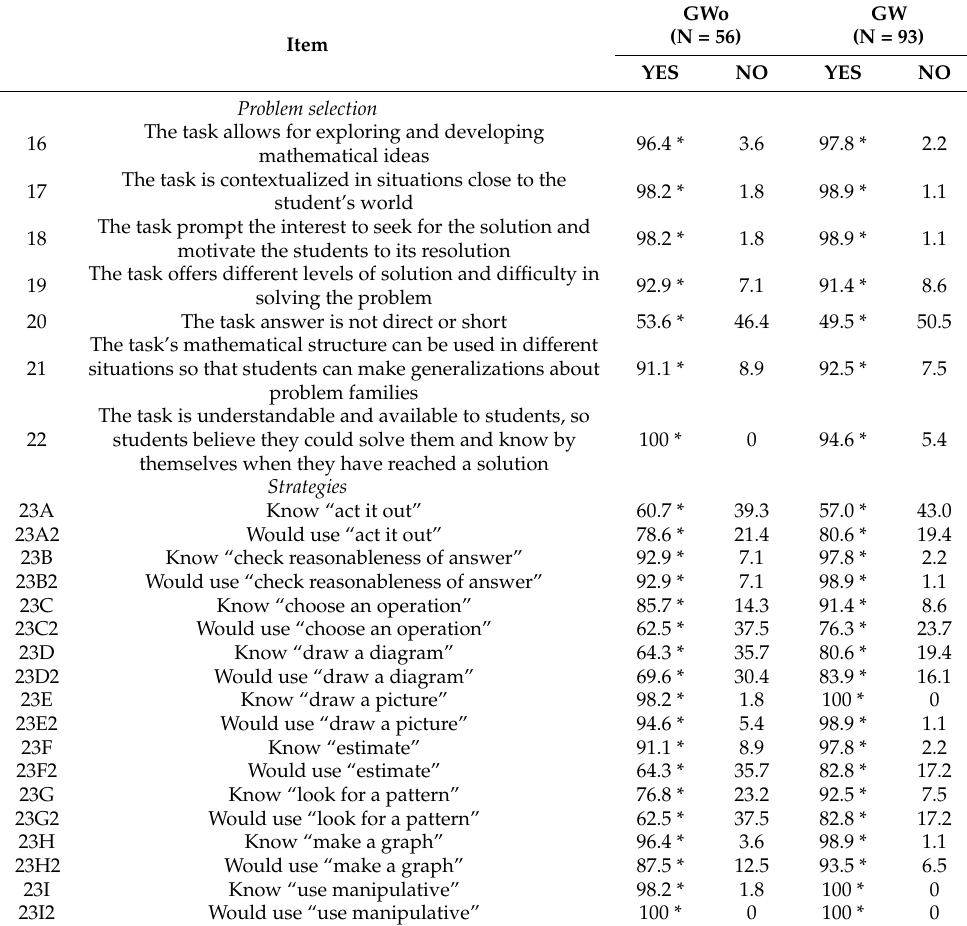
Table 2. Percentages of responses regarding knowledge of PS as worthwhile